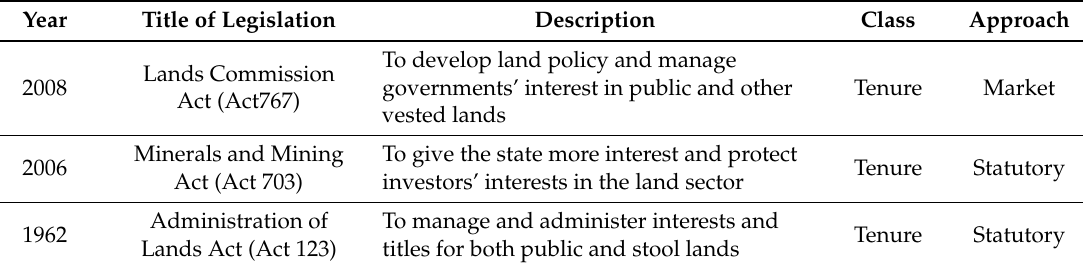
Table 2. Selected pieces of postcolonial land legislation in